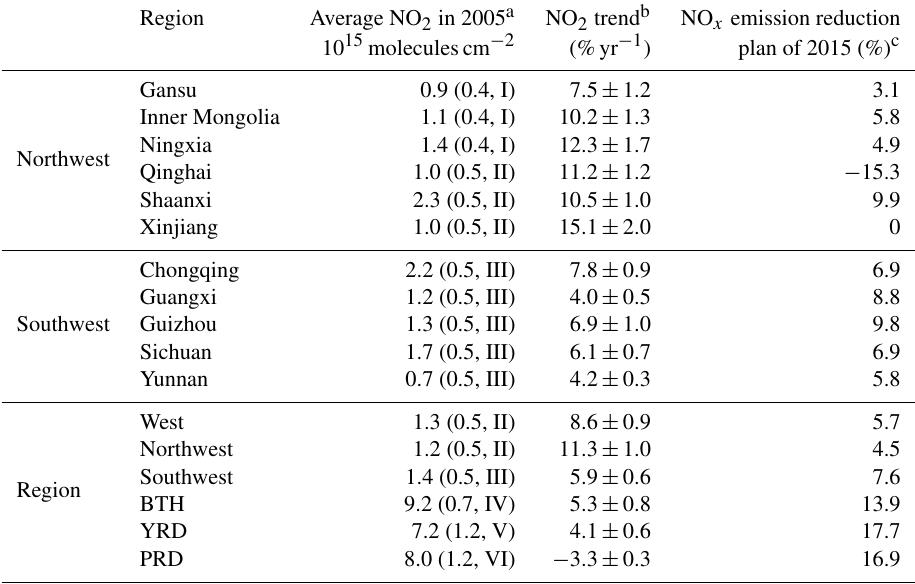
Table 1. Regional trends of OMI NO 2 VCDs over 2005–2013 and NO x emission reduction plan of